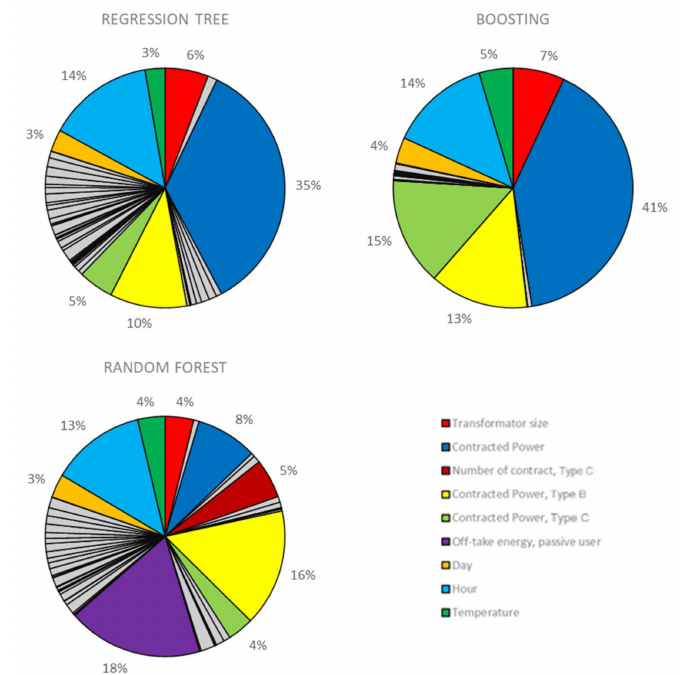
Figure 9. Relative importance of the features according to the embedded feature